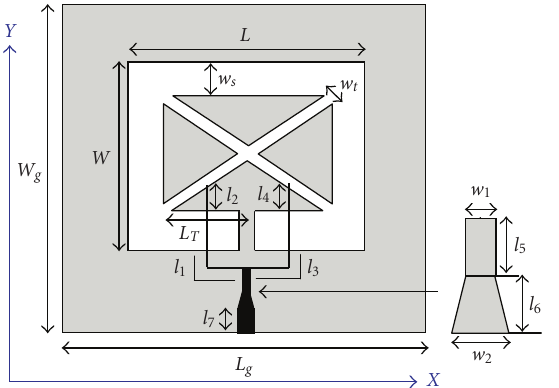
Figure 1: Configuration of the proposed antenna.